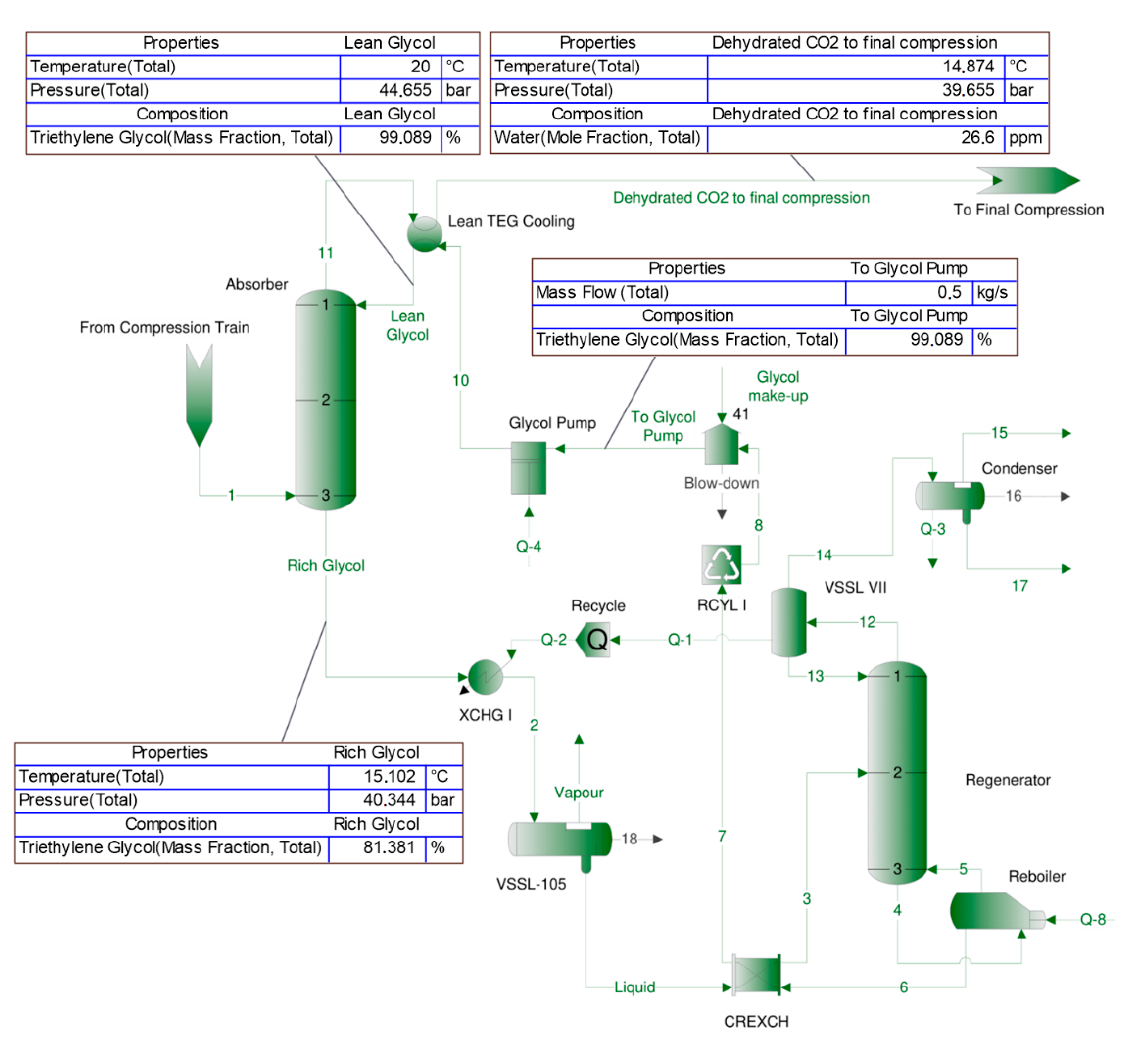
Figure 4. TEG dehydration plant (second part of the plant).